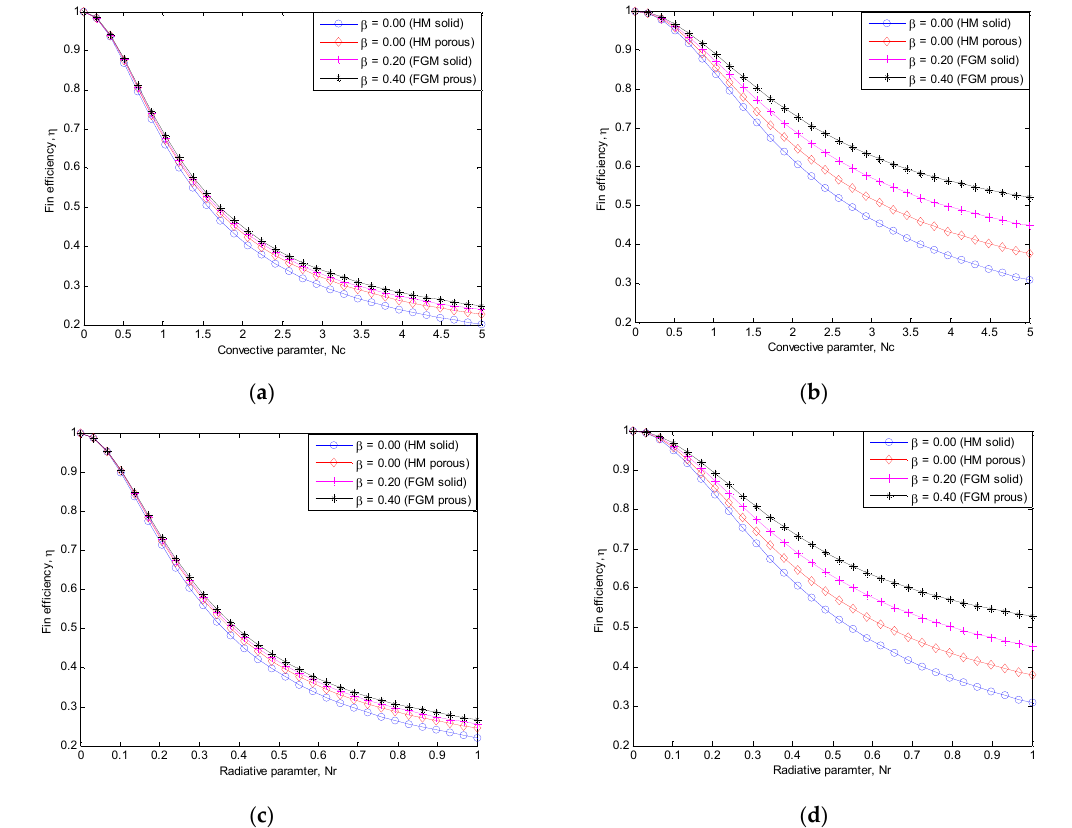
Figure 7. Fin efficiency for the varying thermo-geometric parameter: ( a ) linear-law function when Nc = 1.0, Ra = 0.01, Nr = 0.1; ( b ) power-law function Nc = 1.0, Ra = 0.01, Nr = 0.2; ( c ) linear-law function Nc = 2.0, Ra = 0.01, Nr = 0.1; and ( d ) power-law function Nc = 2.0, Ra = 0.01, Nr = 0.1.